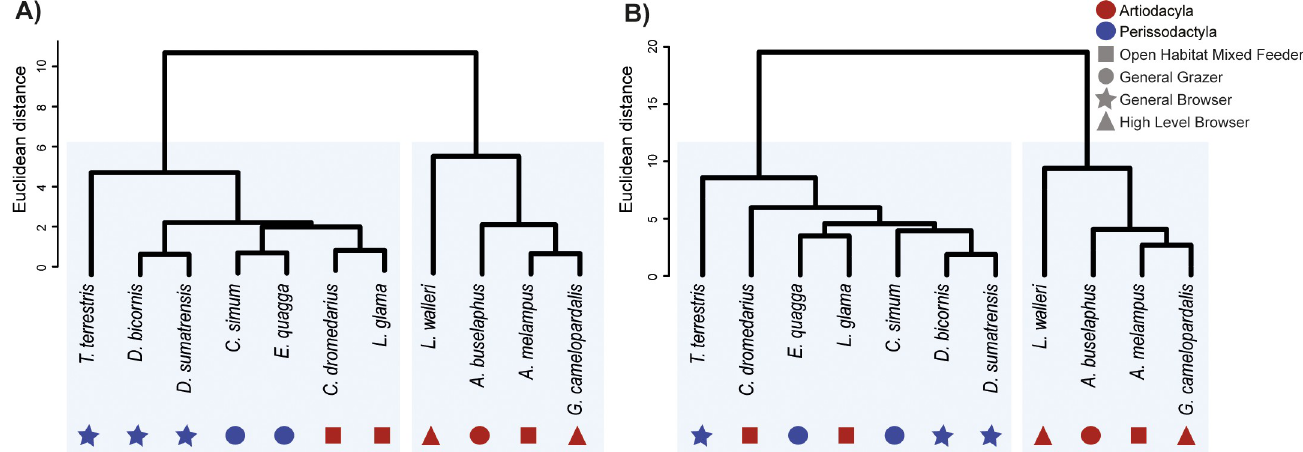
Fig 6. Hierarchical clustering analysis using Ward’s method for a) averaged stress values (MWAM) values and b) percentiles in all the six biting cases.